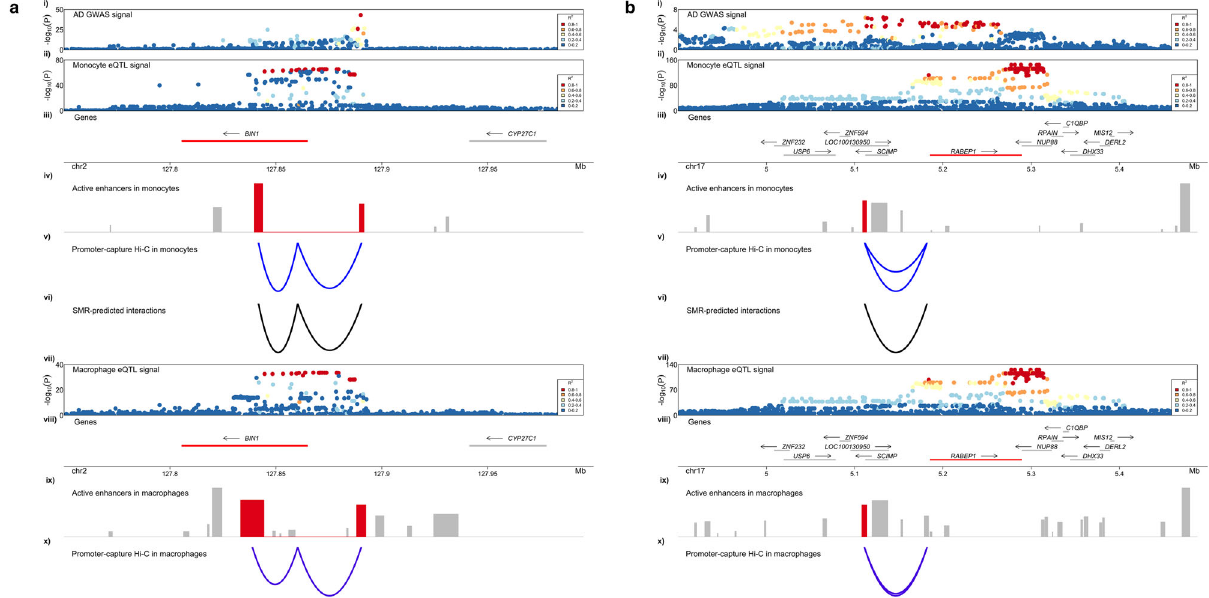
Fig. 2 AD risk enhancers spatially interact with the promoters of BIN1 and RABEP1 and regulate their expression in myeloid cells. a . (i) AD GWAS association signal in the BIN1 locus. (ii) eQTL signal for BIN1 in monocytes obtained from the Cardiogenics study. (iii) Genes that reside in the locus are plotted. Likely target genes of the highlighted AD risk enhancers are shown in red. The arrow indicates the direction of transcription, while the bar indicates the gene body. (iv) Active enhancers in monocytes are plotted. The height of the bar is proportional to the strength of the epigenomic signal. AD risk enhancers that are prioritized through both Hi – C and SMR approaches are highlighted in red. (v) Promoter-capture Hi – C interactions between the BIN1 promoter and the highlighted AD risk enhancers in monocytes. The depth of the arc is proportional to the strength of the interaction. (vi) AD risk enhancer- target gene interactions predicted by SMR analysis of causal associations between chromatin activity and BIN1 expression in monocytes. The depth of the arc is proportional to the strength of the association. (vii) eQTL signal for BIN1 in macrophages obtained from the Cardiogenics study. (viii) Genes that reside in the locus are plotted. Likely target genes of the highlighted AD risk enhancers are shown in red. The arrow indicates the direction of transcription, while the bar indicates the gene body. (ix) Active enhancer elements in macrophages are plotted. AD risk enhancers that interact with the gene promoter are highlighted in red. (x) Promoter-capture Hi – C interactions between the BIN1 promoter and the highlighted AD risk enhancers in macrophages. The depth of the arc is proportional to the strength of the interaction. Both Hi – C and SMR-predicted interactions are anchored at the AD risk enhancer highlighted. b . (i) AD GWAS association signal in the RABEP1 locus. (ii) eQTL signal for RABEP1 in monocytes obtained from the Cardiogenics study. (iii) Genes that reside in the locus are plotted. Likely target genes of the highlighted AD risk enhancers are shown in red. The arrow indicates the direction of transcription, while the bar indicates the gene body. (iv) Active enhancers in monocytes are plotted. The height of the bar is proportional to the strength of the epigenomic signal. AD risk enhancers that are prioritized through both Hi – C and SMR approaches are highlighted in red. (v) Promoter-capture Hi – C interactions between the RABEP1 promoter and the highlighted AD risk enhancers in monocytes. The depth of the arc is proportional to the strength of the interaction. (vi) AD risk enhancer-target gene interactions predicted by SMR analysis of causal associations between chromatin activity and RABEP1 expression in monocytes. The depth of the arc is proportional to the strength of the association. vii) eQTL signal for RABEP1 in macrophages obtained from the Cardiogenics study. (viii) Genes that reside in the locus are plotted.Target genes of the highlighted AD risk enhancers are shown in red. The arrow indicates the direction of transcription, while the bar indicates the gene body. (ix) Active enhancer elements in macrophages are plotted. AD risk enhancers that interact with the gene promoter are highlighted in red. (x) Promoter-capture Hi – C interactions between the RABEP1 promoter and the highlighted AD risk enhancers in macrophages. The depth of the arc is proportional to the strength of the interaction. Hi – C and SMR-predicted interactions are anchored at the AD risk enhancers fi rst selected variants in high to moderate LD (R 2 ≥ 0.8) with the tagging variant in each locus and queried them in Haploreg 30 to (rs1859788-G) in PILRA that is in high LD with the tagging